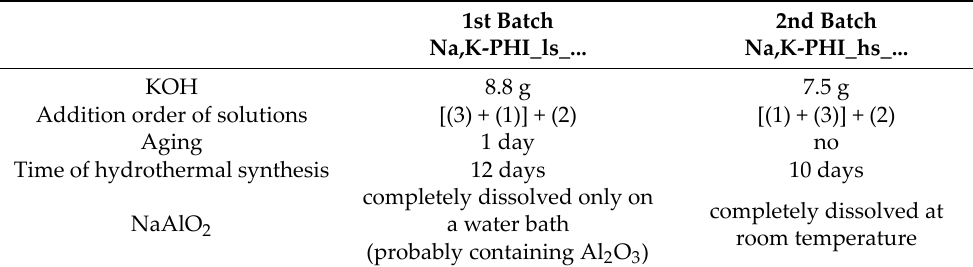
Table 4. Comparison of the main differences of the two PHI syntheses. 1st Batch 2nd Batch Na,K‑PHI_ls_... Na,K‑PHI_hs_... KOH 8.8 g 7.5 g Addition order of solutions [(3) + (1)] + (2) [(1) + (3)] + (2) Aging 1 day no Time of hydrothermal synthesis 12 days 10 days completely dissolved only on completely dissolved at NaAlO 2 a water bath room (probably containing Al 2 O 3 )